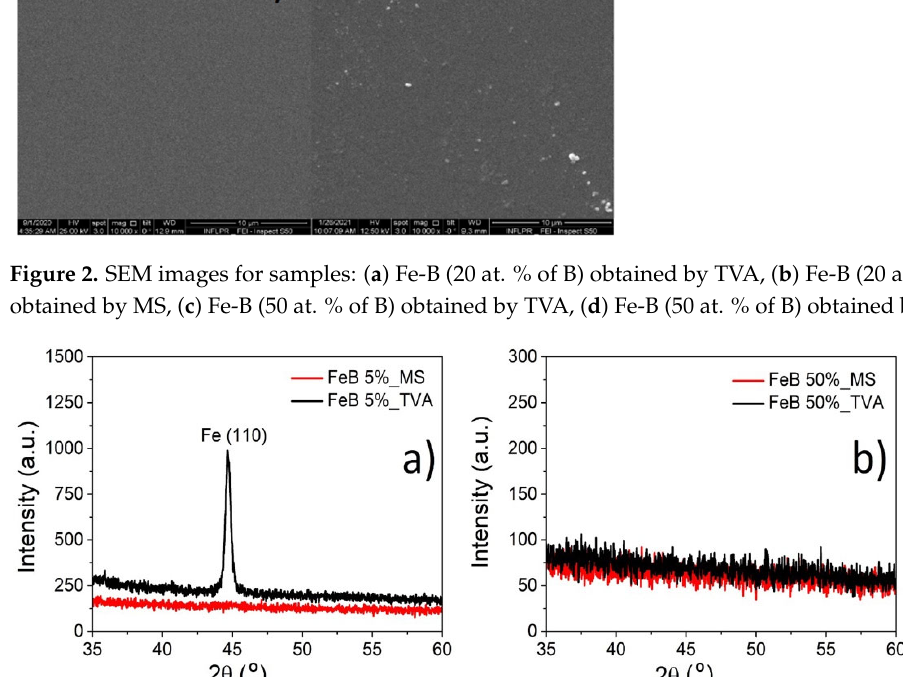
Figure 2. SEM images for samples: ( a ) Fe ‐ B (20 at. % of B) obtained by TVA, ( b ) Fe ‐ B (20 at. % of B) obtained by MS, ( c ) Fe ‐ B (50 at. % of B) obtained by TVA, ( d ) Fe ‐ B (50 at. % of B) obtained by MS .